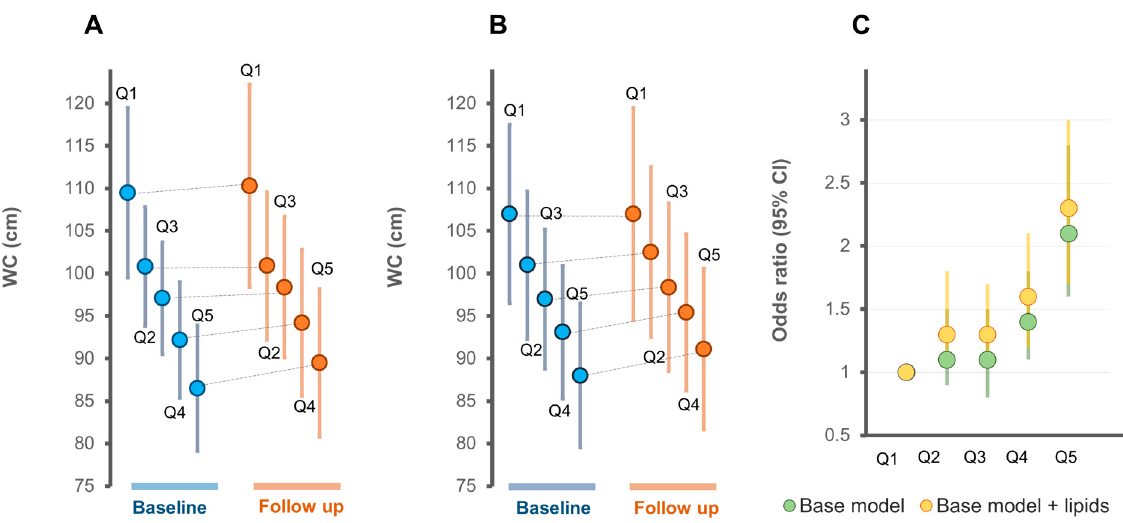
Figure 5. Risk of gaining WC across quintiles of metabolic scores in men. ( A ) Baseline and follow-up WC measures (mean ± SD) across quintiles of the metabolic score derived from the base model, Model 1 and ( B ) from the base model plus lipids, Model 2; ( C ) the relative risk of a >5% WC change across quintiles of the metabolic score. Base model, age, sex, WC, total cholesterol, HDL-C, triglycerides, smoking, exercise time, TV viewing time, energy intake; lipids, all the lipid species associated with change in WC.